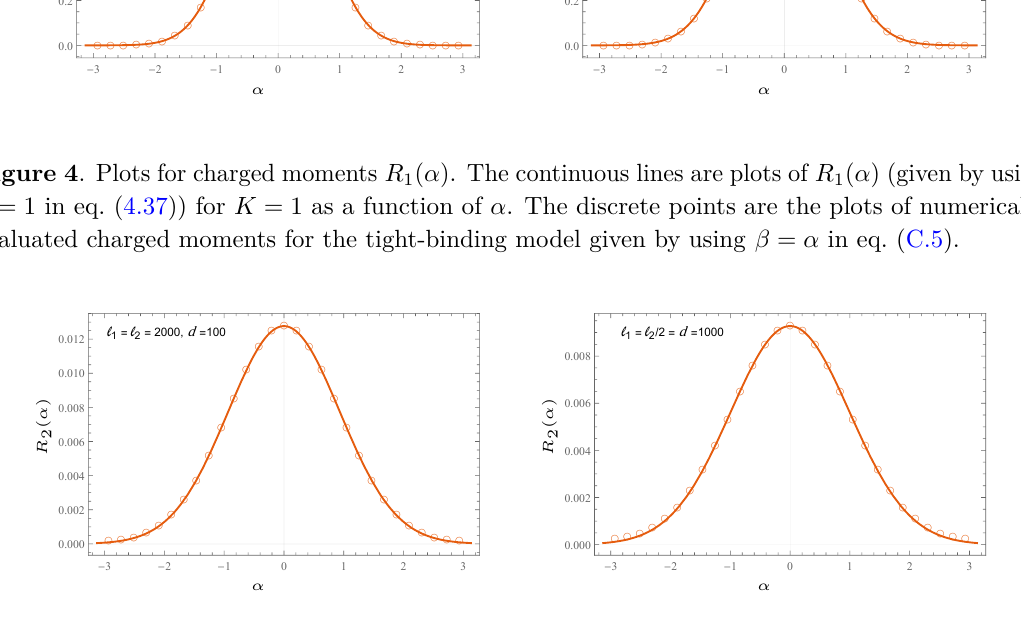
Figure 5 . Plots for charged moments R 2 ( α ) . The continuous lines are plots of R 2 ( α ) (given by using n = 2 in eq. (4.37)) for K = 1 as a function of α . The discrete points are the plots of numerically evaluated charged moments for the tight-binding model given in eq.